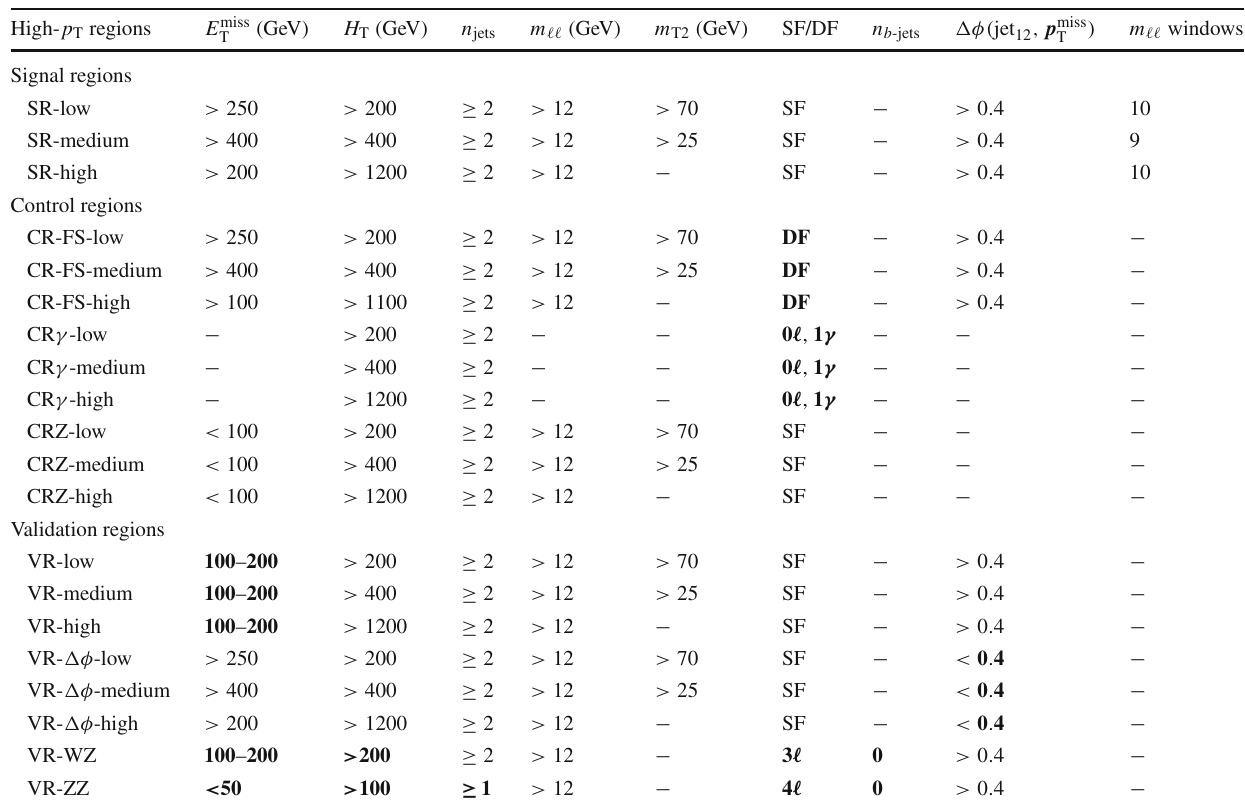
Table 3 Overview of all signal, control and validation regions used in the high- p T edge and on- Z searches. The flavour combination of the dilepton pair is denoted by either “SF” for same-flavour or “DF” for different-flavour. All regions require at least two opposite-charge leptons with p T > { 50 , 25 } GeV, with the exception of the three γ CRs, which require zero leptons and one photon, and the diboson CRs